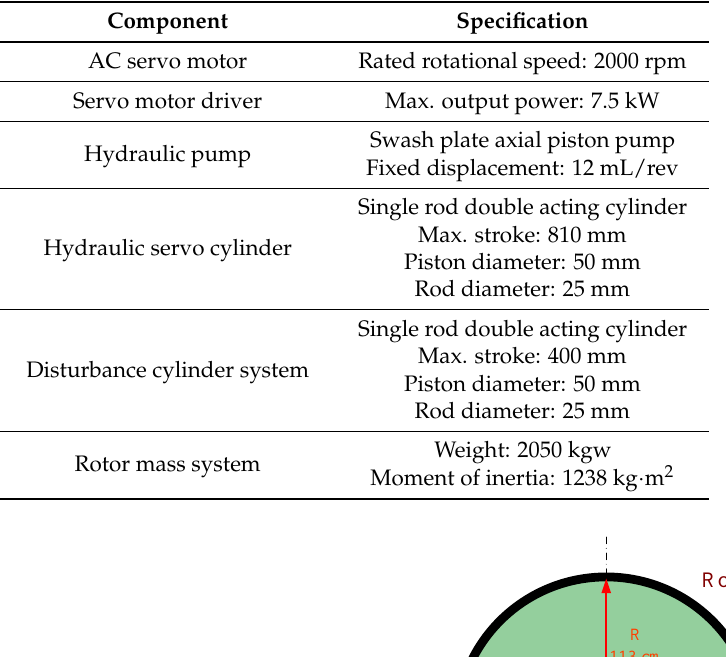
Table 1. Specifications of the test rig.